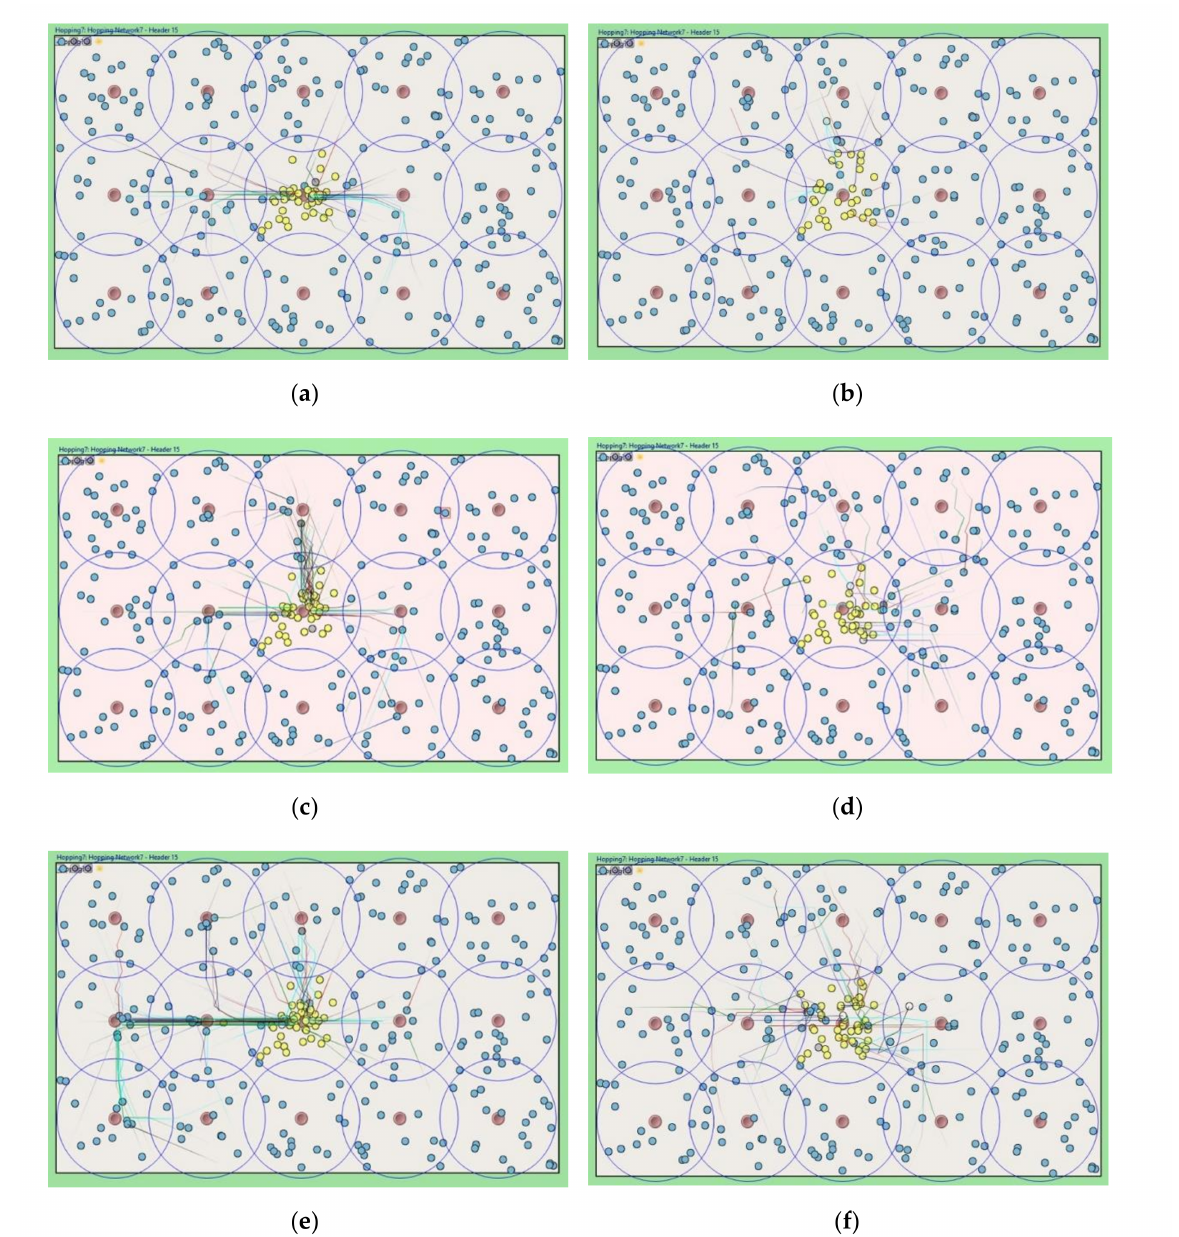
Figure 9. Simulation snapshots for each relocation protocols in terms of HELLO message interval time. ( a ) Previous scheme w. 60 min; ( b ) Proposed scheme w. 60 min; ( c ) Previous scheme w. 30 min; ( d ) Proposed scheme w. 30 min; ( e ) Previous scheme w. 15 min; ( f ) Proposed scheme w. 15